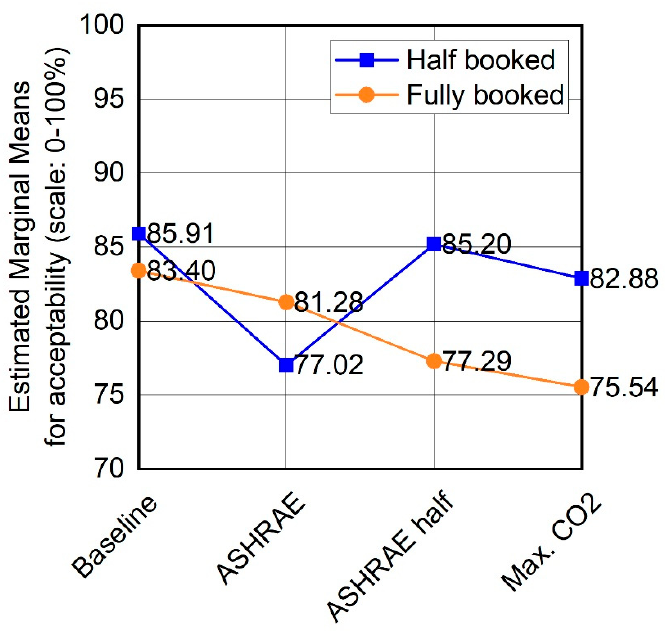
Figure 16. Acceptability ratings on a scale from 0–100 controlled for age, sex, smoking and self- reported multiple chemical sensitivity of participants.